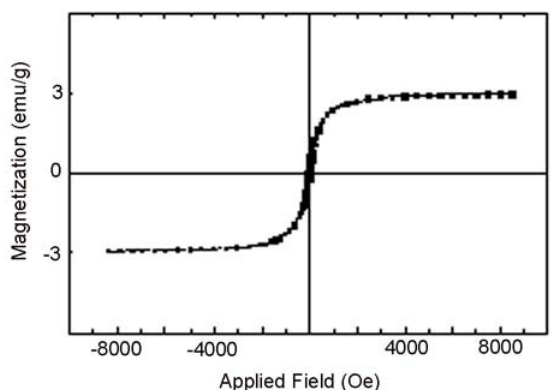
Fig. 8. The hysteresis loop of starch-CuFe nanocomposite